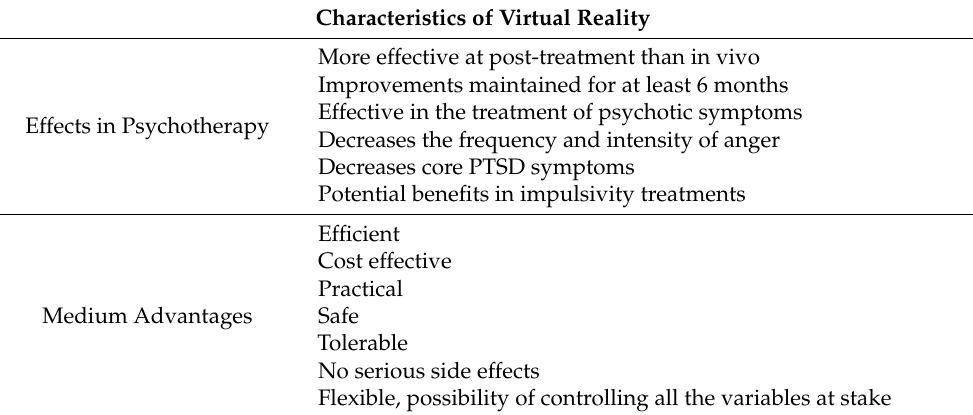
Table 1. Characteristics of Virtual Reality concerning the effects found in psychotherapy treatments and the advantages of this